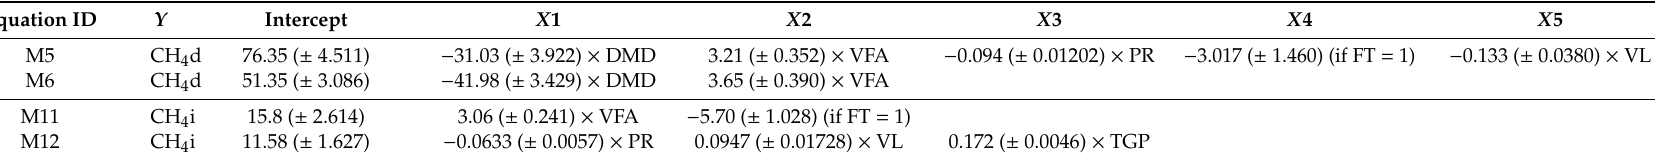
Table 5. Best performing equations from the meta-analysis 1